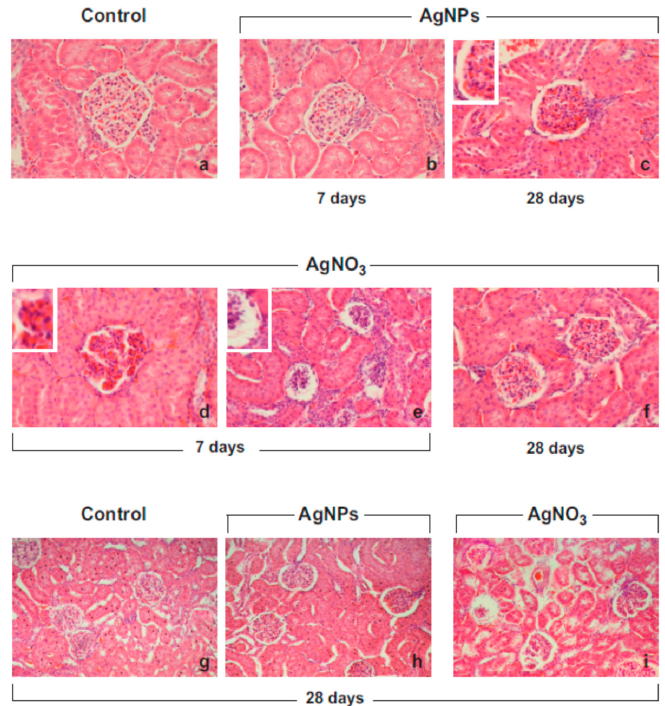
Figure 2. Representative H&E-stained cortical renal specimens from control animals ( a , g ) and rats exposed to AgNPs ( b , c , h ) or AgNO 3 ( d – f , i ), 7 and 28 days post-instillation. The physiological renal structure is clearly well preserved in control rats ( a , g ), while moderate morphological alterations are manifest in the renal cortex of the treated animals, at both evaluated time points. Seven days